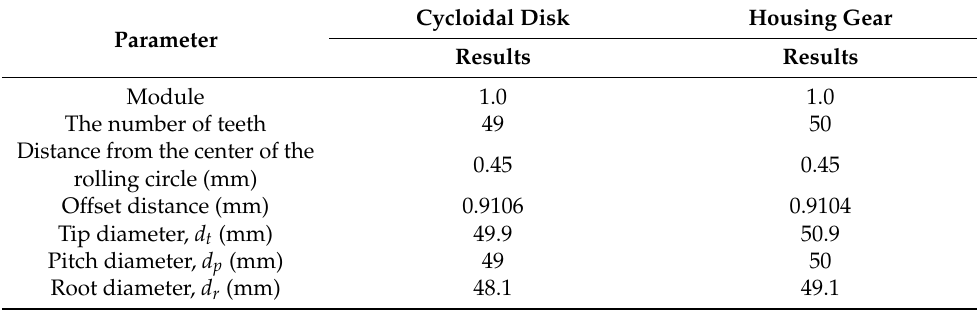
Table 2. Results of the designed cycloidal reducer.